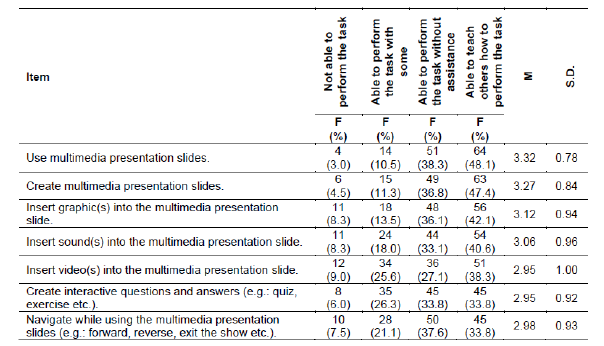
Table 10. Descriptive Statistics for Items on Media Communication using the Laptop